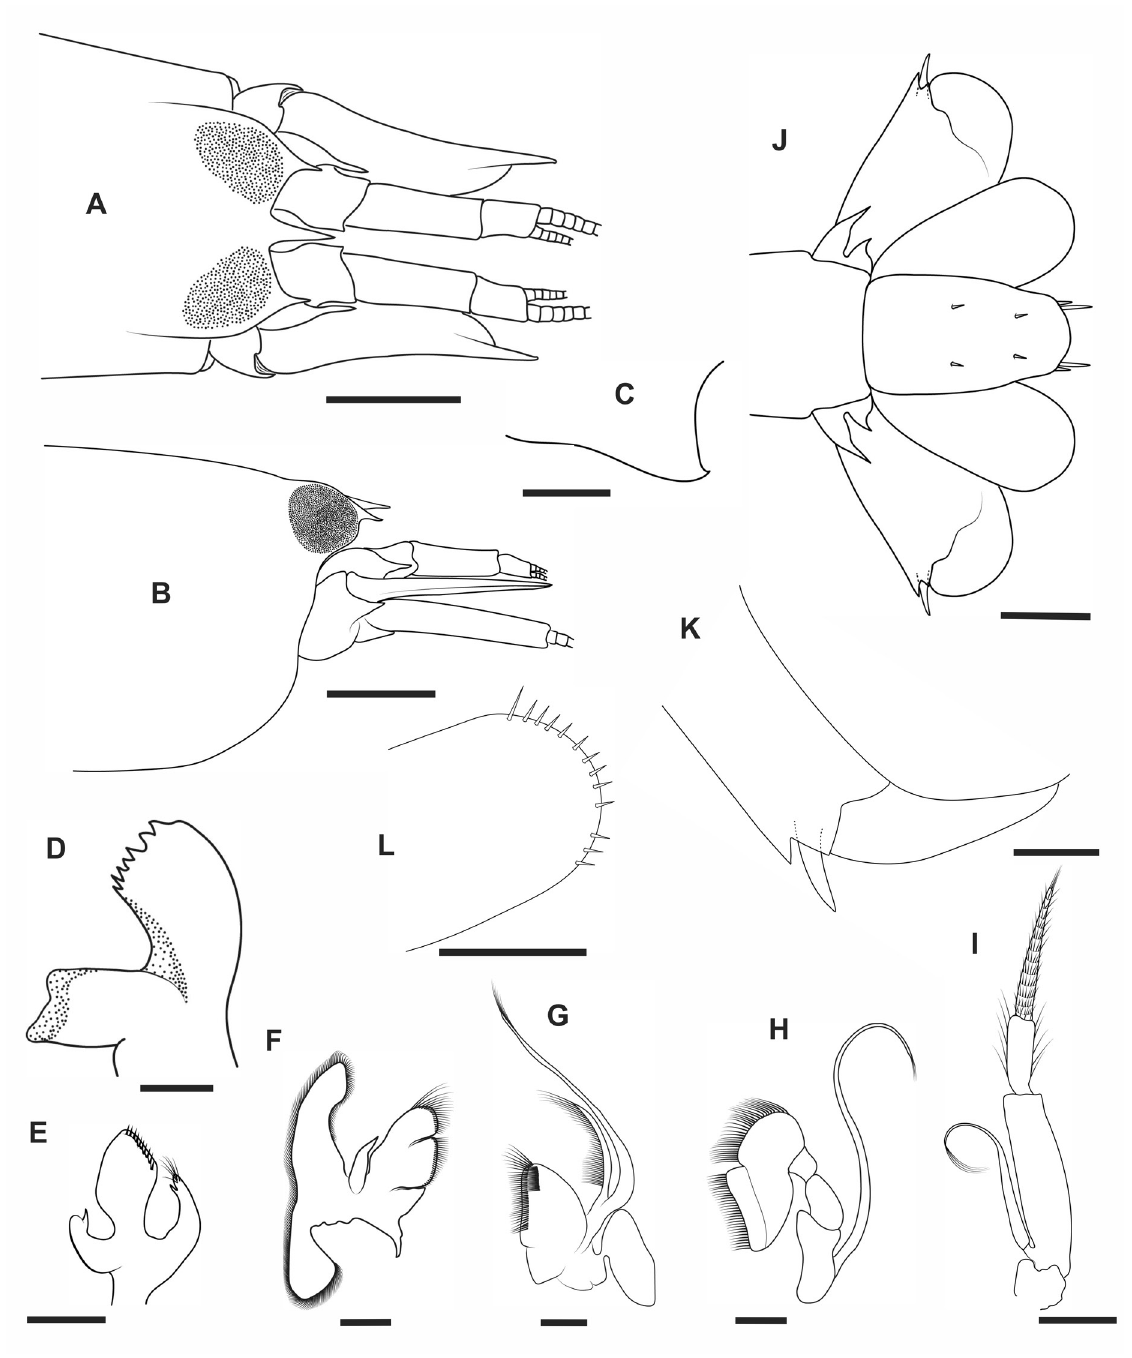
Fig. 1. Alpheus ramosportoae sp. nov. A–D . Holotype, ♂, from off Recife, state of Pernambuco, northeastern Brazil (MOUFPE 19470). A . Carapace and cephalic appendages, dorsal view (setae omitted). B . Same, lateral view. C . Tooth on ventromesial carina of antennular peduncle. D . Left mandible, mesial view. E–L . Paratype, ♂, from seamounts of the North Chain, Ceará, northeastern Brazil (MOUFPE 13703). E . First maxilla, lateral view. F . Second maxilla, lateral view. G . First maxilliped, lateral view. H . Second maxilliped, lateral view. I . Third maxilliped, lateral view. J . Telson and uropods, dorsal view (setae omitted). K . Uropod, detail of the distolateral angle of the exopod. L . Uropod, detail of the posteerior margin of endopod. Scale bars: A–B, J = 1 mm; C–I, K–L = 0.5